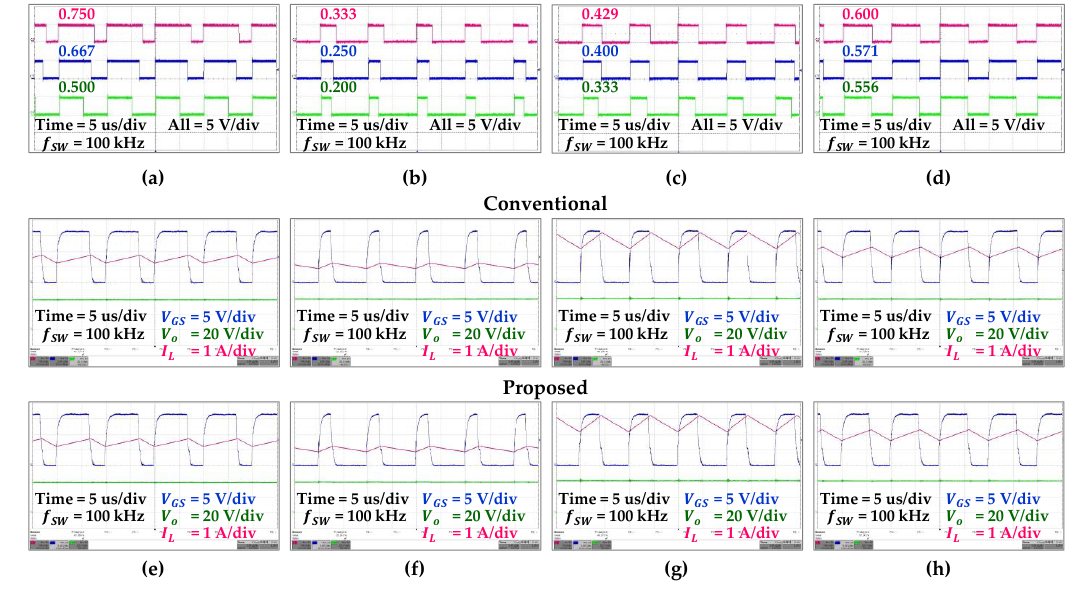
Figure 8. Waveforms of PWM, inductor current 𝐼 𝐿 , gate-source voltage 𝑉 𝐺𝑆 , and output voltage 𝑉 𝑜 : PWM of ( a ) buck; ( b ) boost; ( c ) buck-boost step-down; ( d ) buck-boost step-up; 𝐼 𝐿 ,𝑉 𝐺𝑆 ,𝑉 𝑜 of ( e ) buck (at d = 0.667; 𝐼 𝐿 = 1.5 A); ( f ) boost (at d = 0.250, 𝐼 𝐿 = 0.75 A); ( g ) buck-boost step-down (at d = 0.400, 𝐼 𝐿 = 1.5 A); and ( h ) buck-boost step-up (at d = 0.571, 𝐼 𝐿 = 0.75 A).